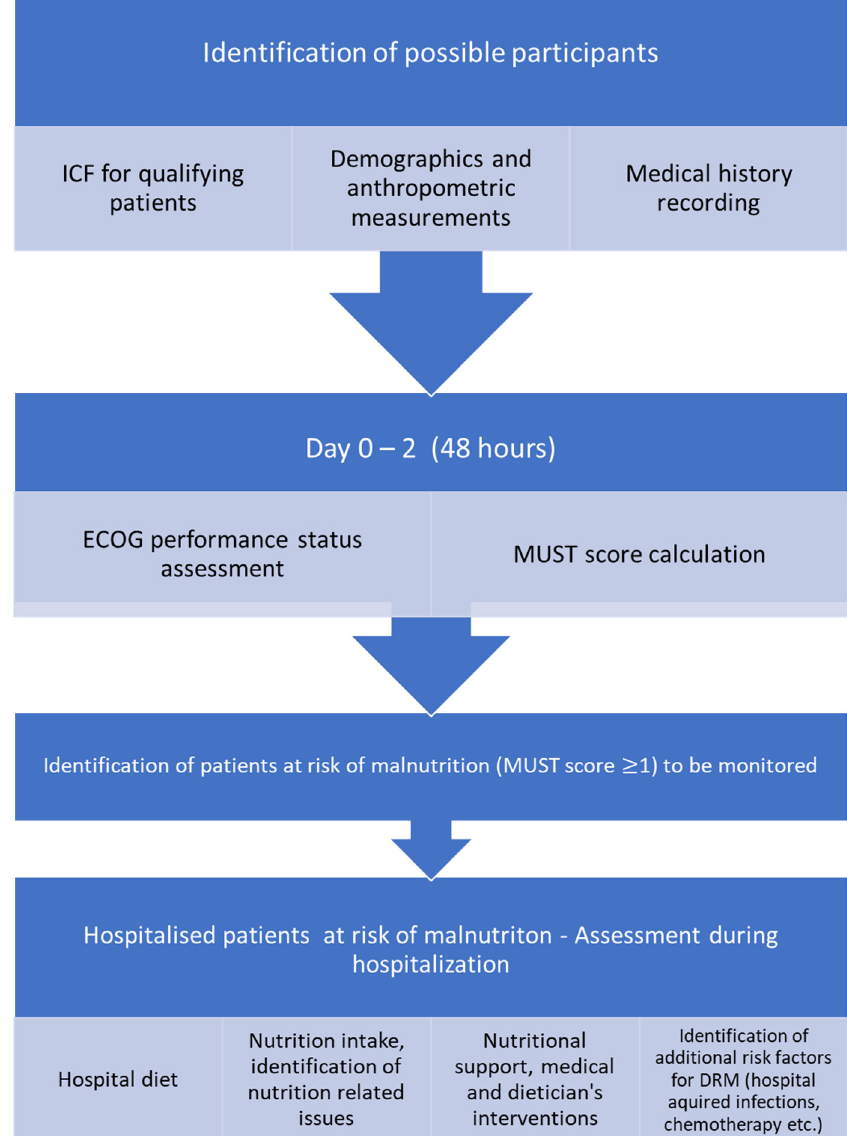
Figure 1. Flow chart of the audit.